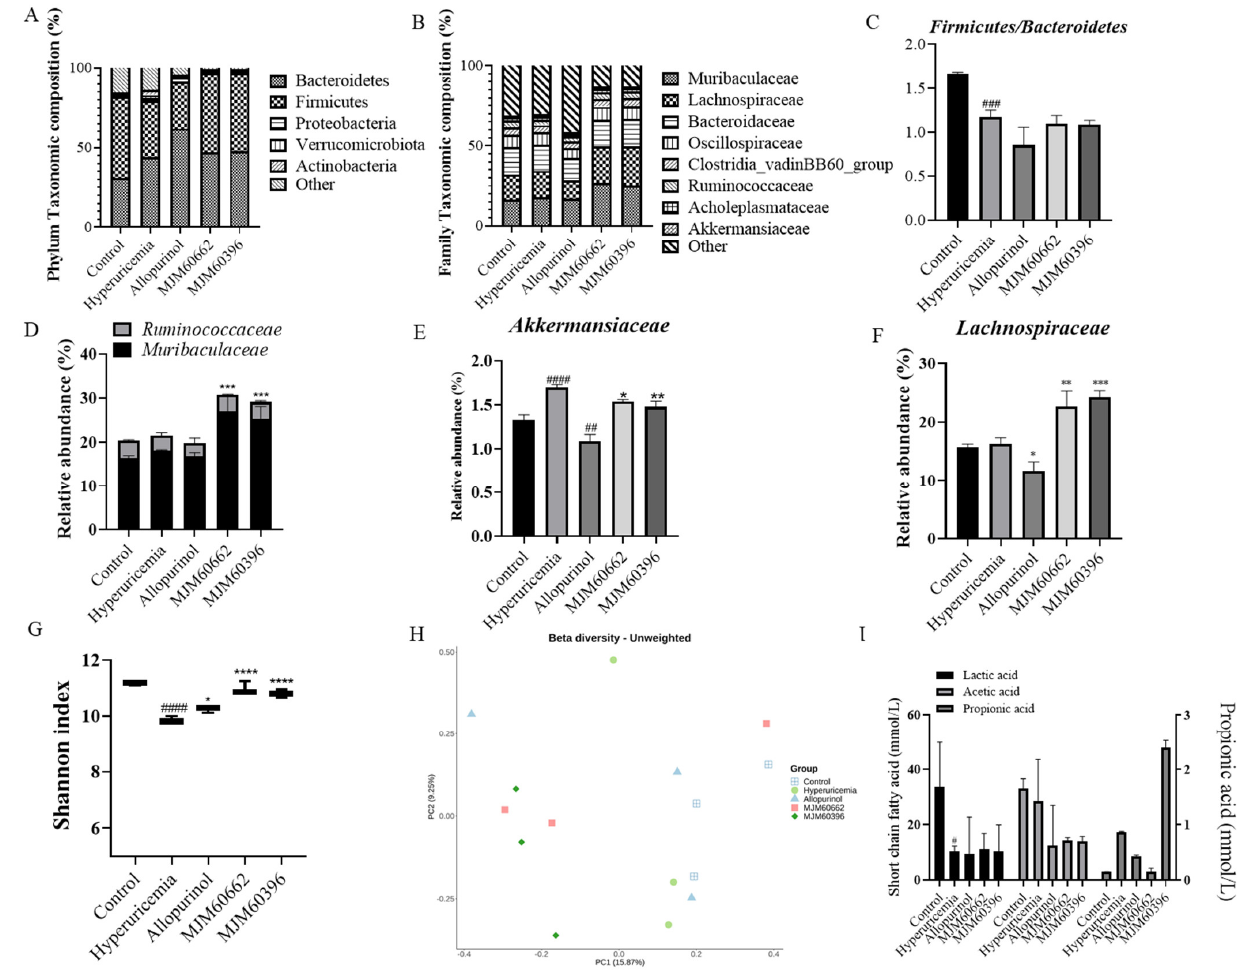
Figure 7. LAB supplementation modulated the composition of the gut microbiota. ( A ) Taxonomic composition at the phylum level. ( B ) Taxonomic composition at the family level. ( C ) Firmicutes/Bacteroidetes (F/B) ratio ( D ) Relative abundance of Muribaculaceae and Ruminococcaceae . ( E ) Relative abundance of Akkermansiaceae . ( F ) Relative abundance of Lachnospiraceae . ( G ) Alpha − diversity is indicated by the Shannon index. ( H ) Beta-diversity comparisons. The colors of the boxplots and dots represent the different groups analyzed according to the legend. ( I ) The amount of SCFAs was measured in the feces of each group. Quantities of lactic acid, acetic acid, propionic acid, were measured by GC − MS. ## p < 0.01 ### p < 0.001, #### p < 0.0001 compared with control group, * p < 0.05, ** p < 0.01, *** p < 0.001, **** p < 0.0001 compared with the hyperuricemia